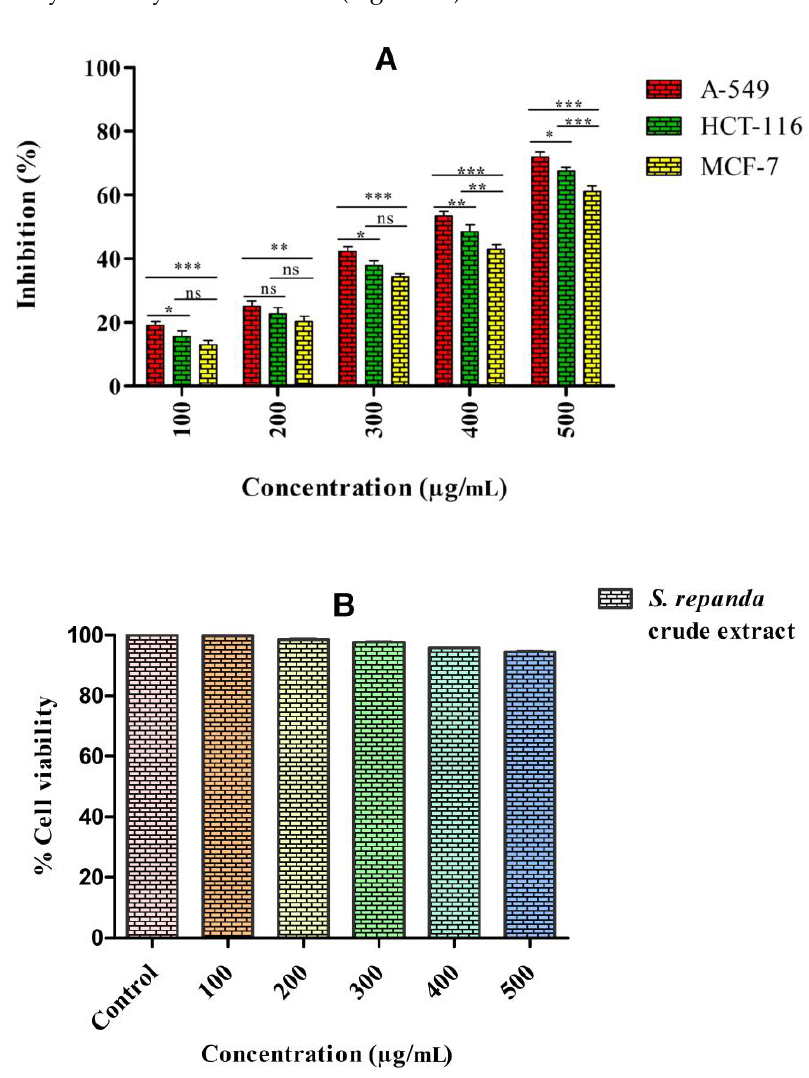
Figure 2. ( A ) Anticancer activity against three different human cancer cell lines, i.e., breast (MCF-7), colon (HCT-116) and lung (A549). ( B ) Cytotoxicity of S. repanda crude extract against human normal colon cells (CRL-1831). Error bars indicate SDs ( ± standard deviation) of three independent experiments. NS > 0.05, * p < 0.05, ** p < 0.005, *** p <